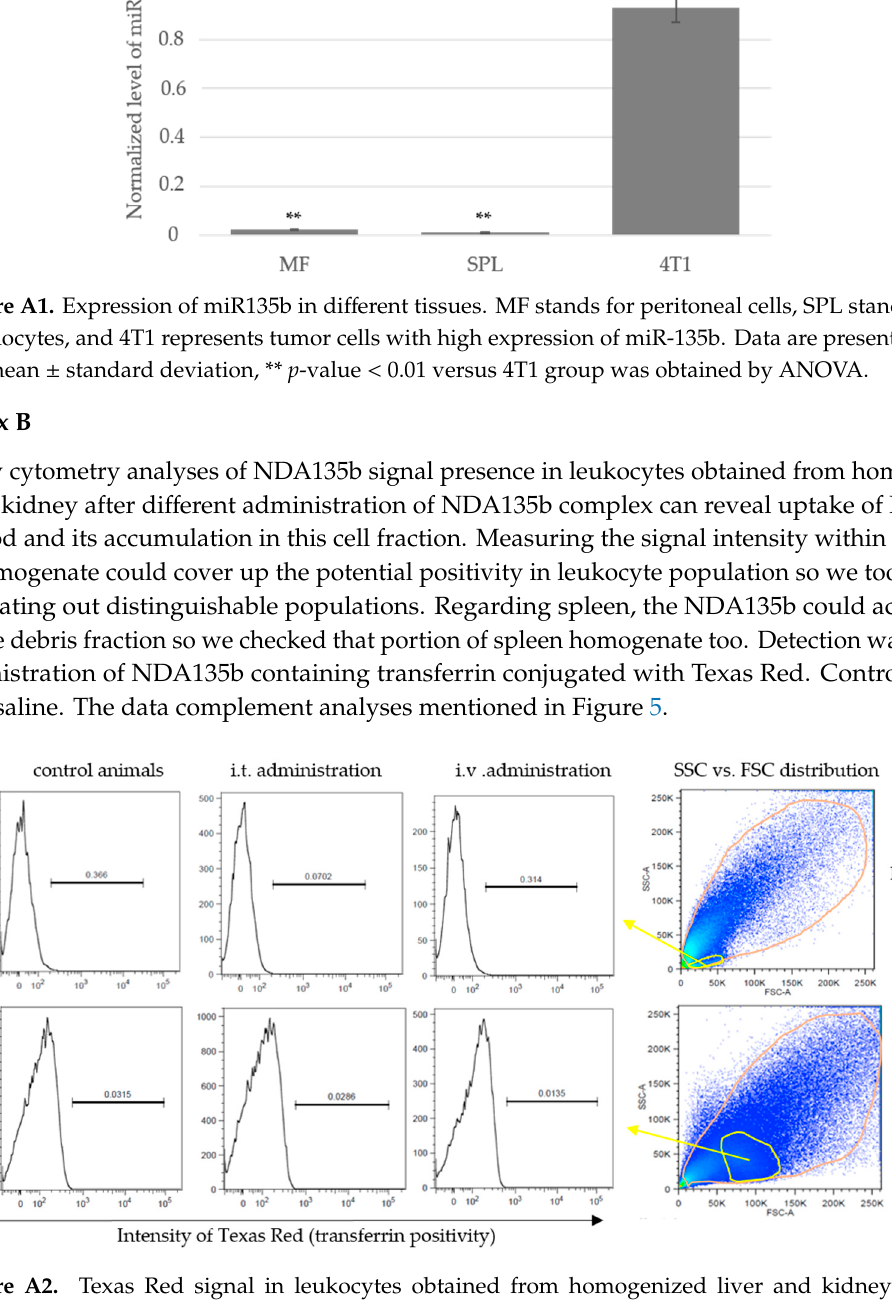
Figure A3. Texas Red signal in debris/erythrocytes fraction of unfiltered spleen samples from animals administered with NDA135b.